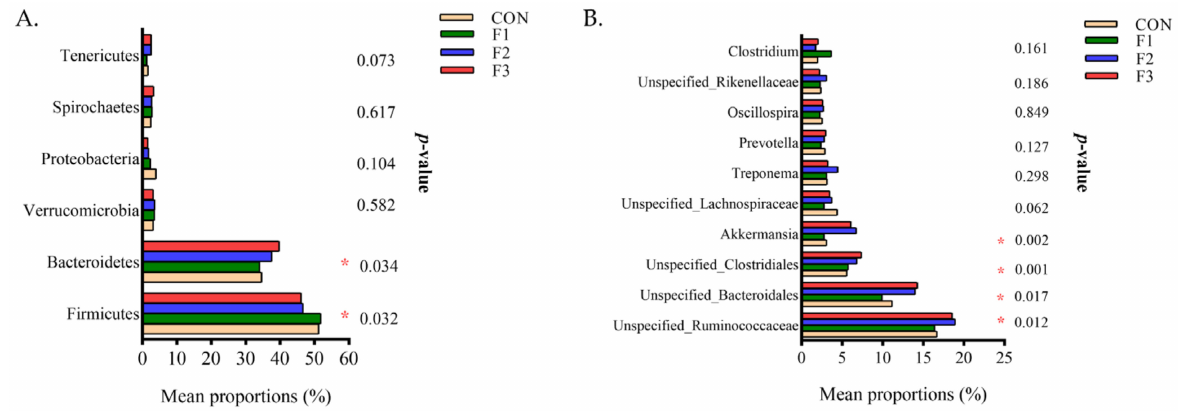
Figure 8. Analysis for different bacterial at phylum ( A ) and genus ( B ) level among four dietary treatments. CON, basal diet; F1, basal diet + 0.1% fucoidan; F2, basal diet + 0.3% fucoidan; F3, basal diet + 0.5% fucoidan. * p <